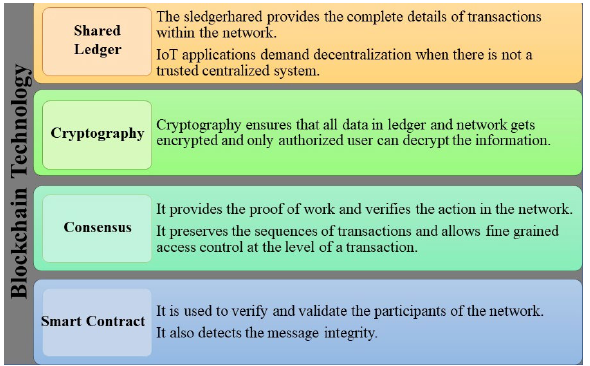
Figure 6. Blockchain technology strengths